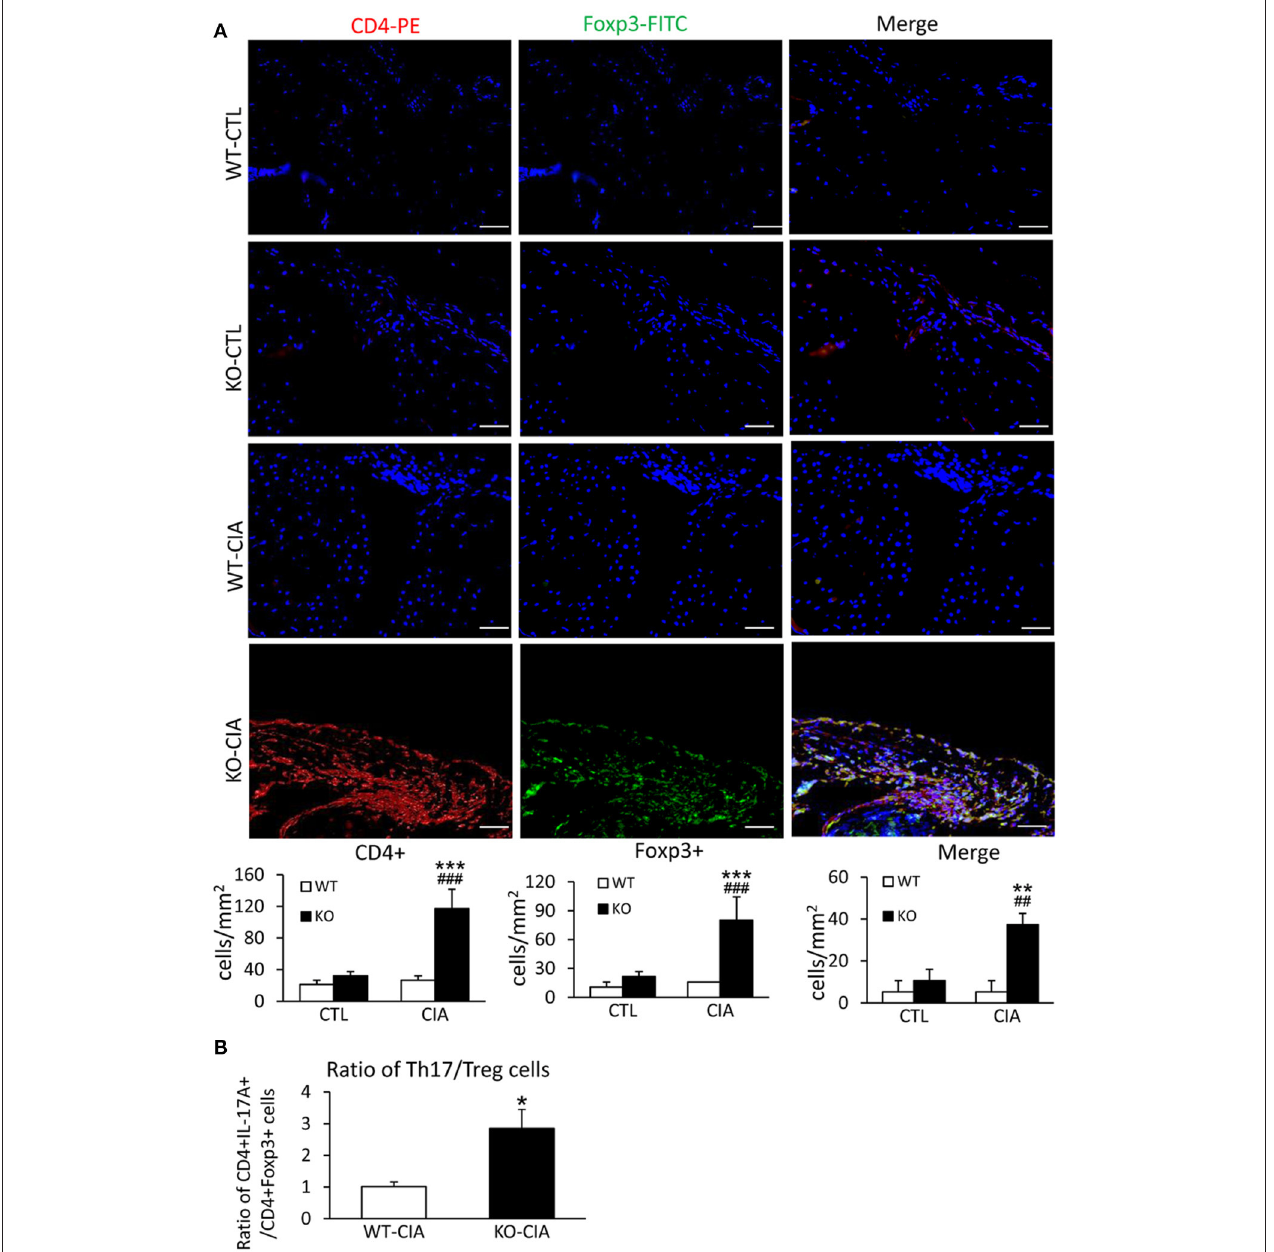
FIGURE 7 | Deletion of Smad7 increases Treg cells but causes imbalance of Th17 over Treg response with the high ratio of CD4 + IL-17A + /CD4 + Foxp3 + cells in the synovial tissues of CIA in CD-1 mice. (A) Two-color immunofluorescence of CD4 + Foxp3 + cells in synovial tissues in CD-1 mice. (B) The ratio of CD4 + IL-17A + cells/ CD4 + Foxp3 + cells in synovial tissues of CIA mice. Data are expressed as mean ± S.E. for group of 8mice. * p < 0.05, ** p < 0.01, *** p < 0.001 vs. control (CTL); ## p < 0.01, and ### p < 0.001 vs. CIA-Smad7-WT mice. Scale bar, 50 µ